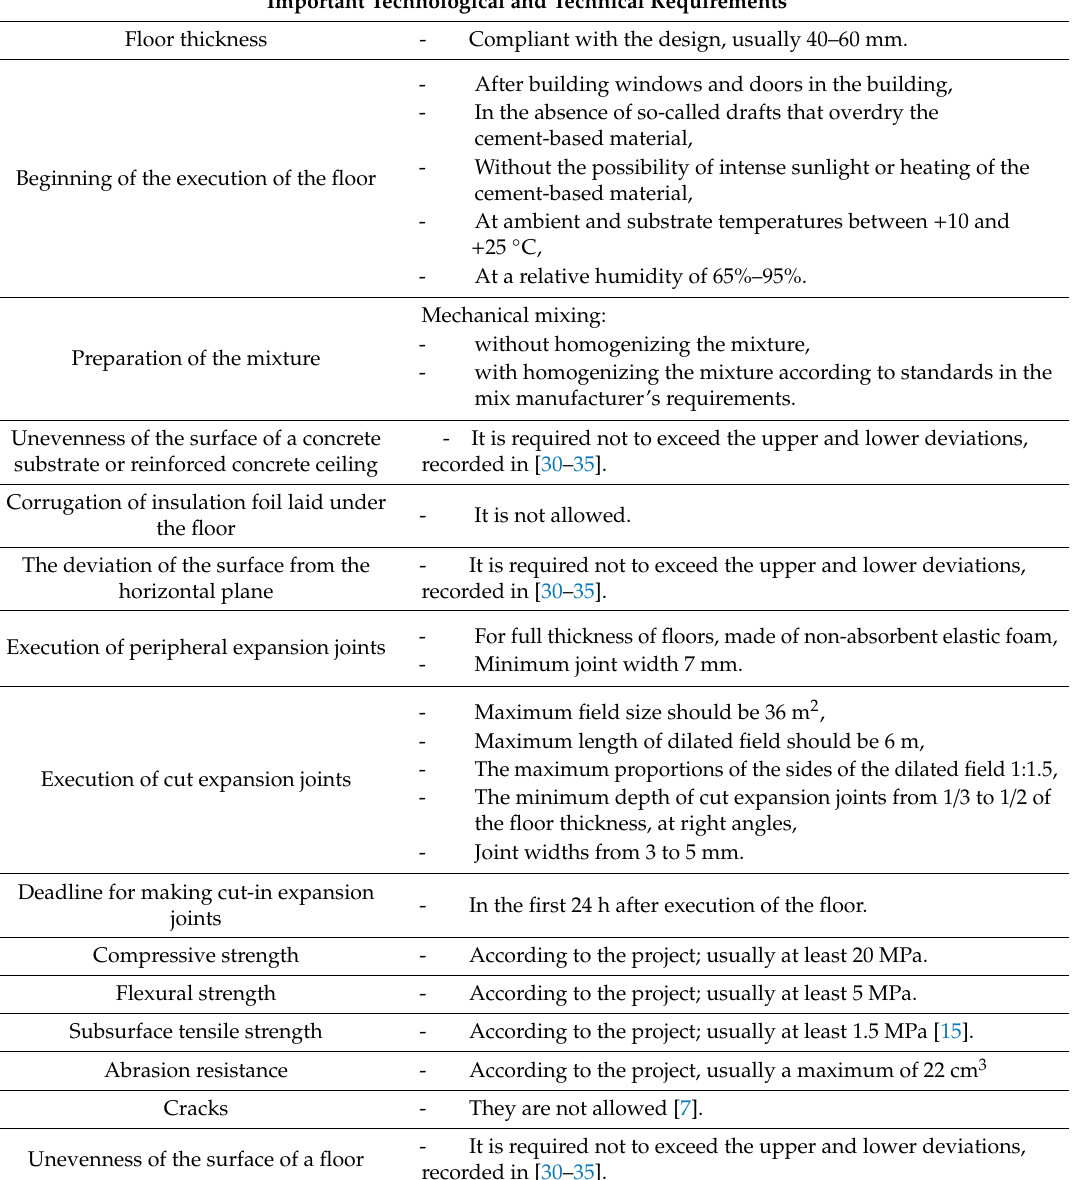
Table 1. A synthetic summary of the major technological and technical requirements for the execution of floors made of cement-based